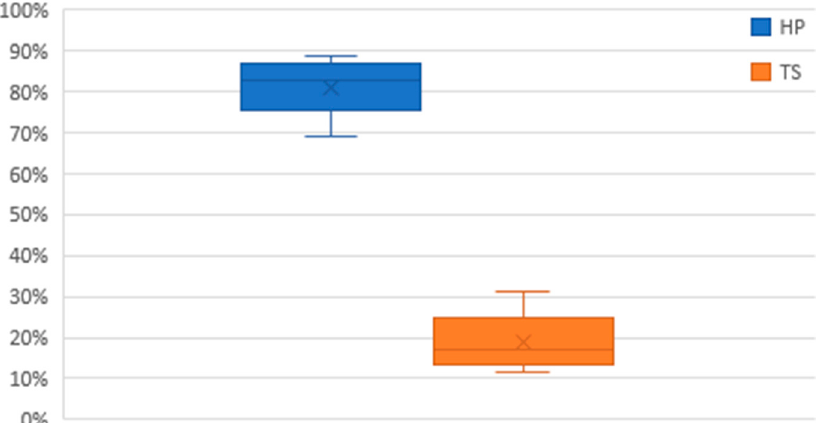
Figure 10. Box and whisker plot of the heating demand percentage directly delivered by the heat pump ( HP ) and thermal storage ( TS ).